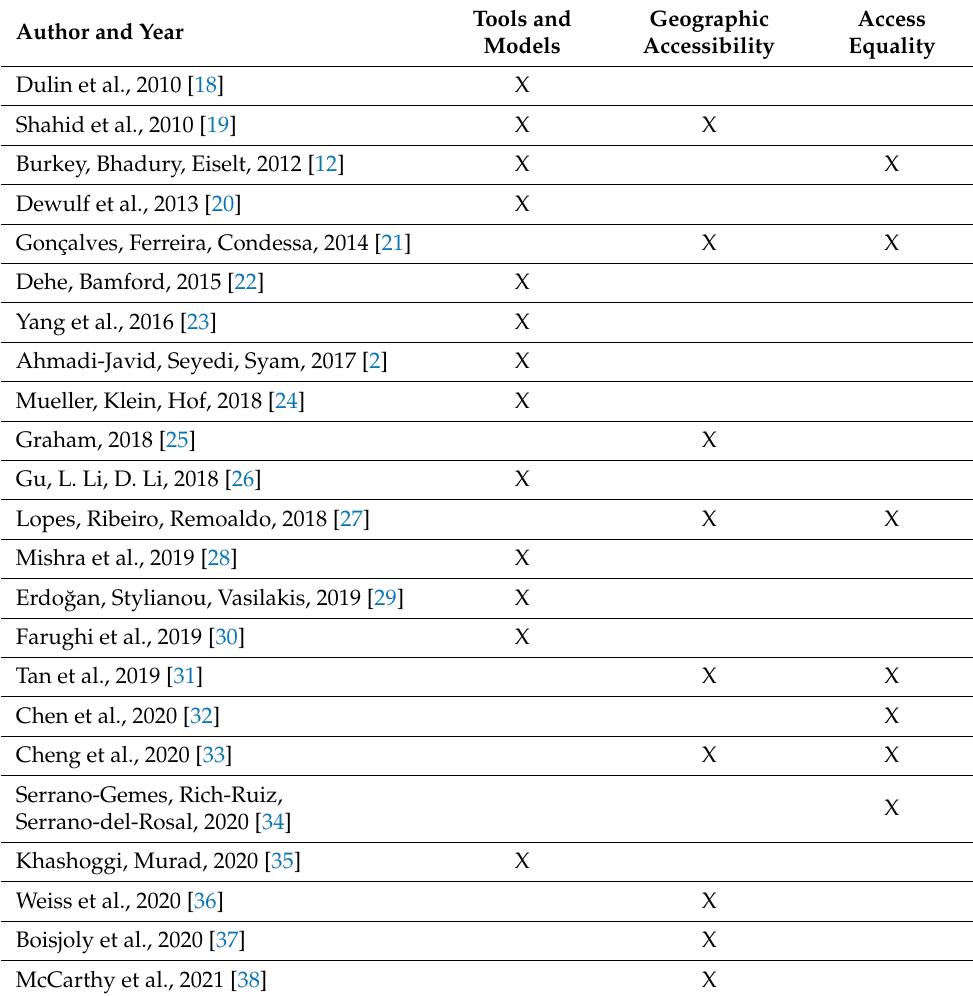
Table 4. Key themes involved in siting of healthcare care facilities. (X—Key theme alignment with individual study